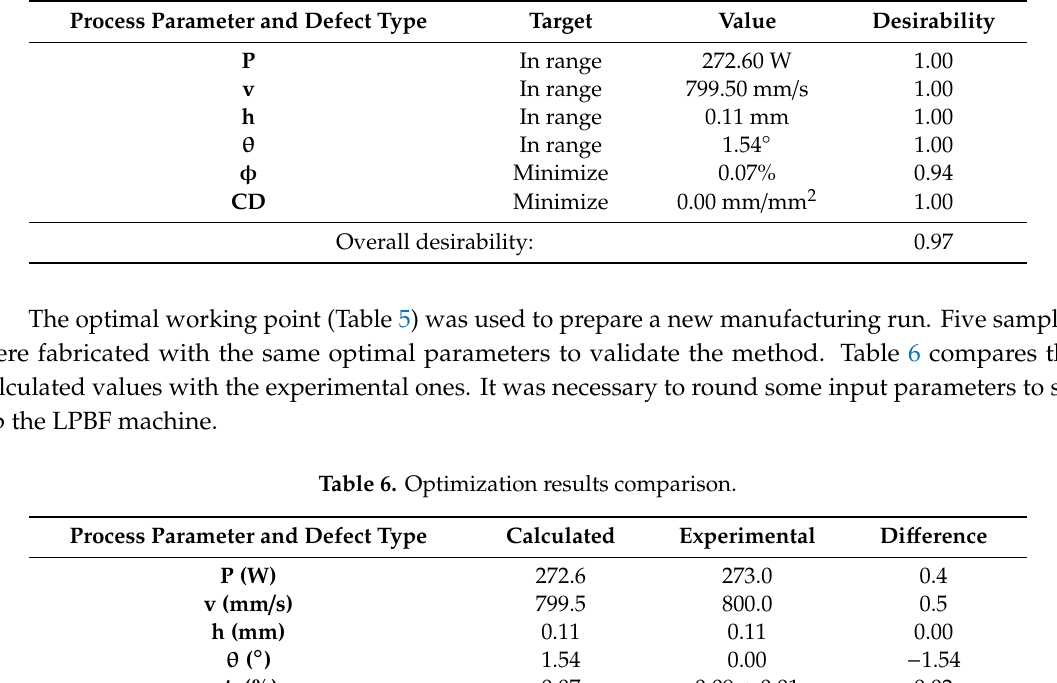
Table 5. Optimization results.